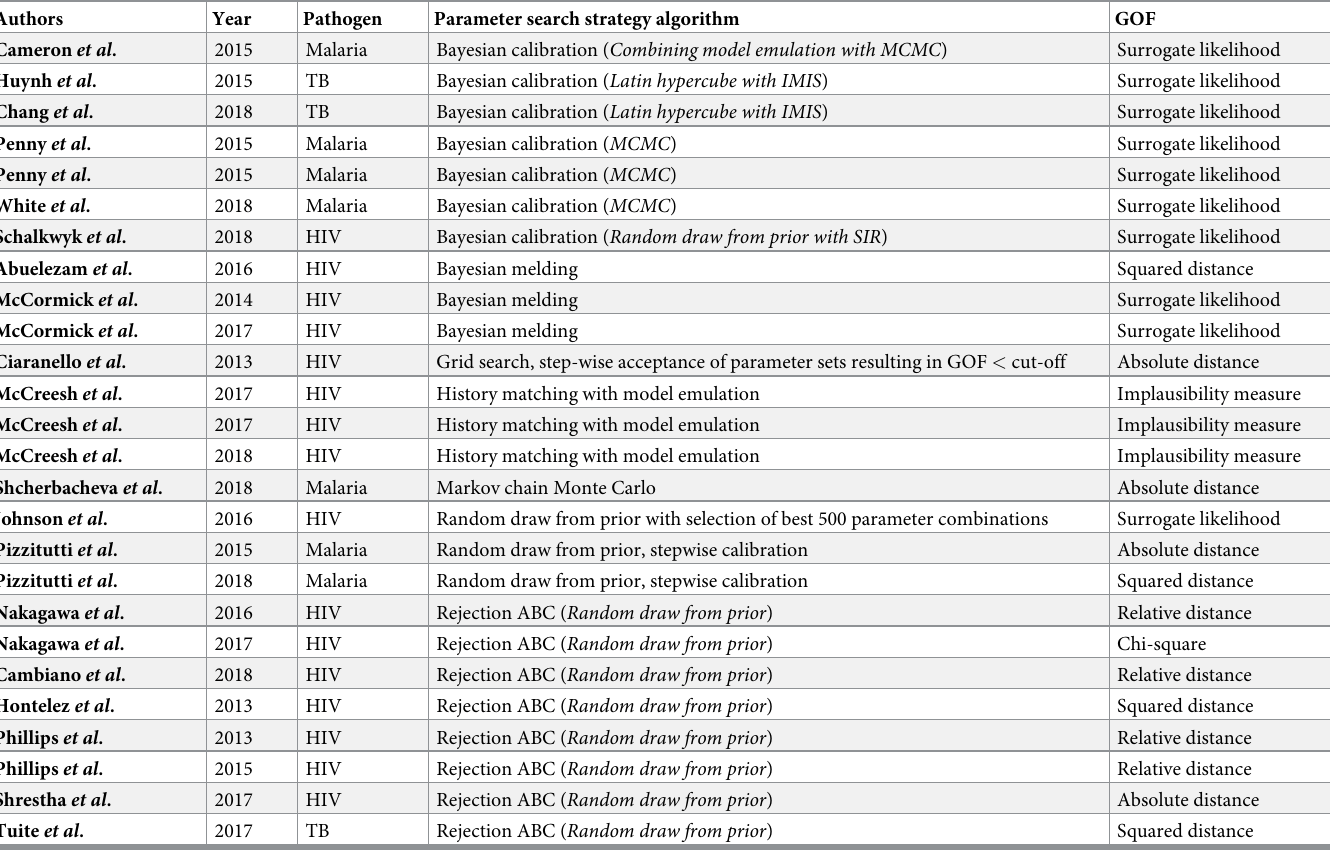
Table 2. Details of the calibration methods in articles using sampling algorithms for calibration, sorted by parameter search strategy